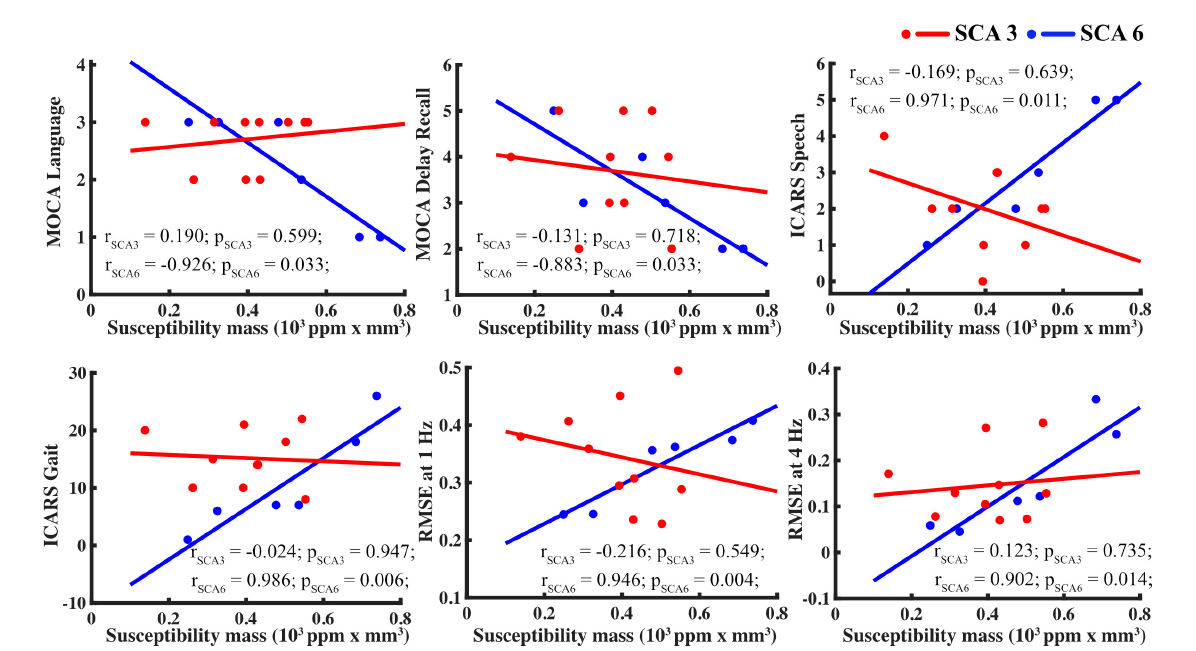
FIGURE5 For SCA6 but not SCA3, susceptibility mass in the basal ganglia (using the caudate as proxy) correlated with supplemental measures. Tasks, clockwise from upper left: MOCA language, MOCA delayed recall, ICARS speech, finger tapping RMSE at 4 and 1 Hz, and ICARS